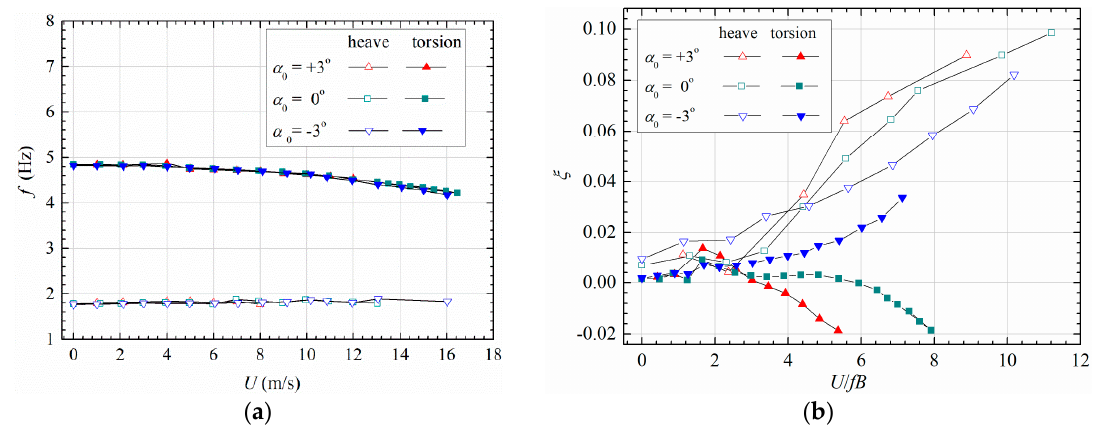
Figure 4. Evolution of linear modal parameters with reduced velocity: ( a ) frequency, ( b ) damping (Case A1, B1 and C1).